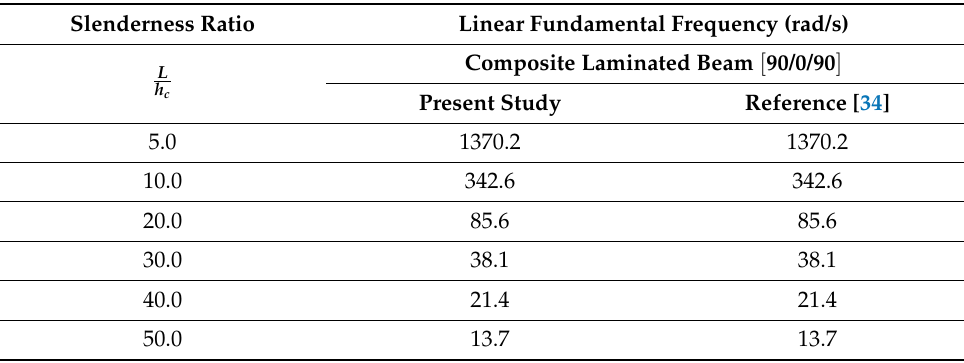
Table 3. Comparison of linear fundamental frequency.